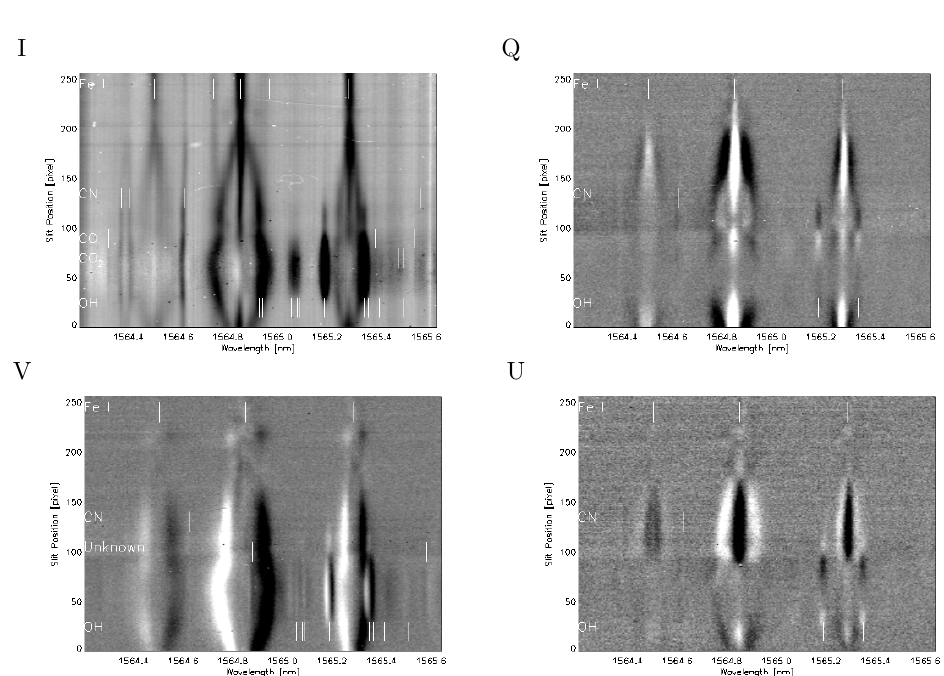
Figure 9: A figure showing the polarization spectra of a sunspot. The spectrograph slit crossed a sunspot umbra, and the Zeeman spitting in Stokes I, Q, U, and V are shown in this figure, with the continuum intensity removed from the Stokes I panel. The 1565 nm 𝑔 = 3 line is shown at the center of each panel, and other atomic and molecular lines are identified in each spectrum. Image reproduced with permission from Penn et al. (2004a), copyright by